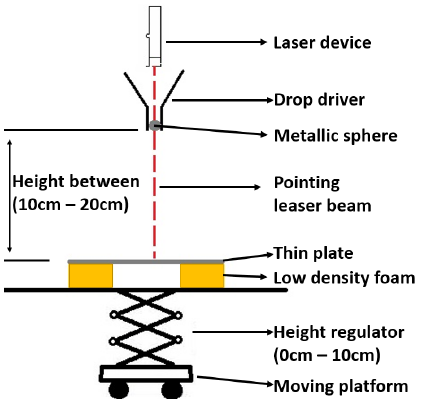
Figure 4. Visualization of the steel ball drop